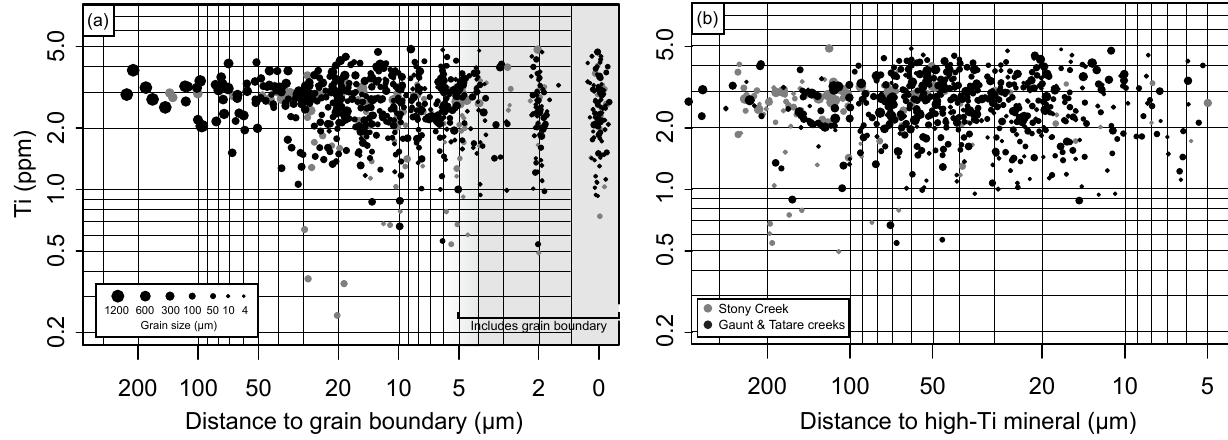
Figure 7. Ti concentrations in quartz vs. the distance (in thin-section plane) from the analysis center to the nearest (a) grain boundary (of any type) or (b) dark mineral that might act as a potential Ti source or sink such as biotite or Fe–Ti oxide. The increased presence of low Ti concentrations closer to grain boundaries (a) results from recrystallization and diffusion during deformation at decreasing temperatures. The lack of a clear trend in panel (b) suggests that Ti-in-quartz concentrations were not strongly affected by proximity to neighboring Ti-rich phases and that diffusion of Ti along grain boundaries was not a limiting factor in Ti-in-quartz concentrations. Data from Cross et al. (2015) are plotted in panel (a) but are not available for panel (b) . The data are jittered along the x axis in order to increase visibility.